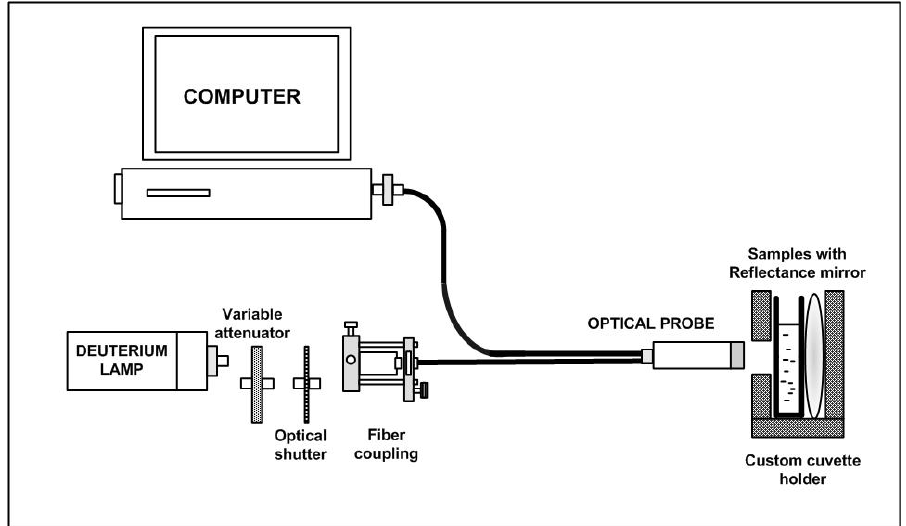
FIGURE 1. The experimental layout for characterization of saliva samples Figure 7. Experimental layout for characterization of saliva samples in the detection of amylase